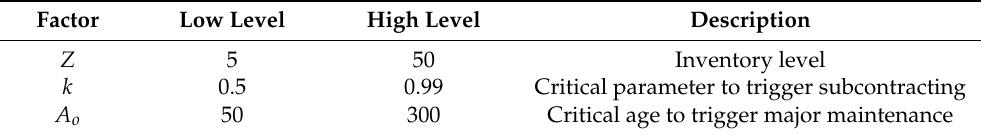
Table 4. Domains of the independent